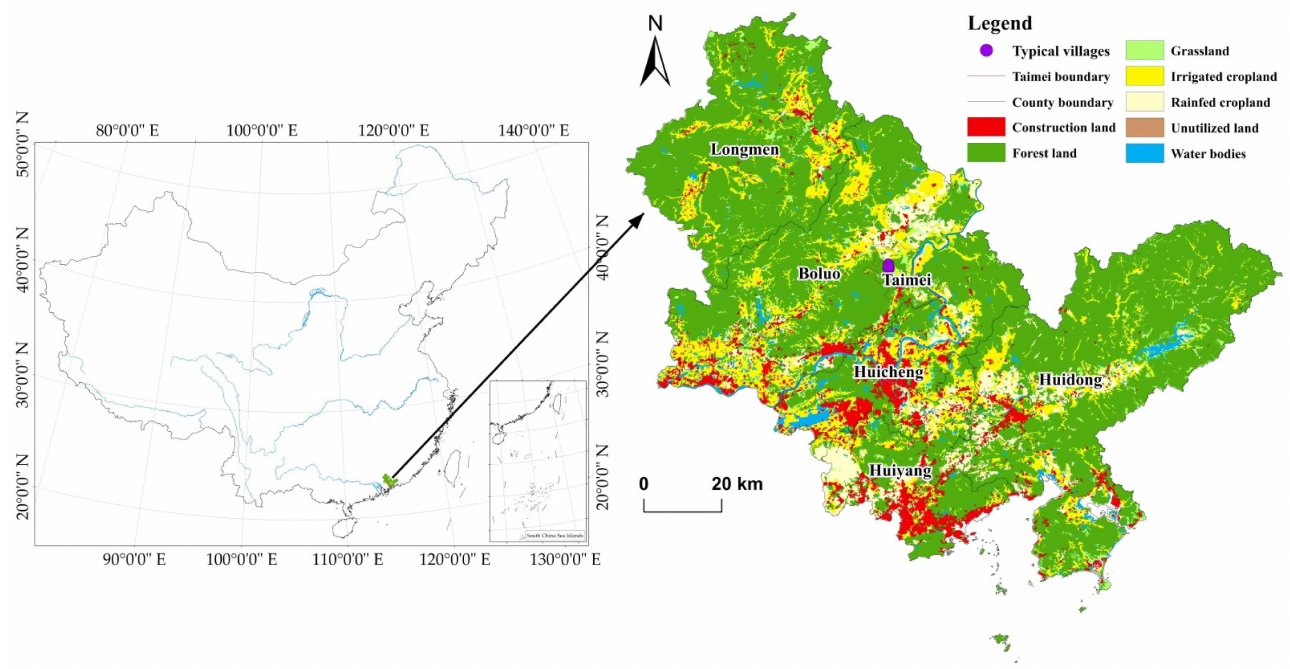
Figure 1. Location of the study